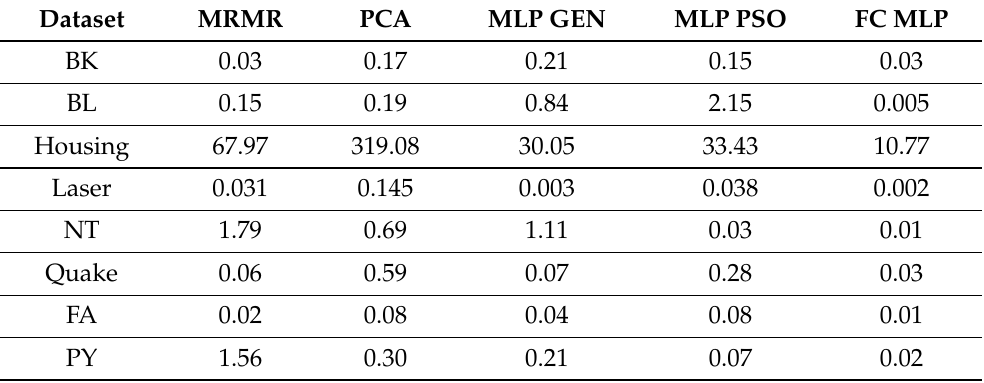
Table 5. Experiments for regression